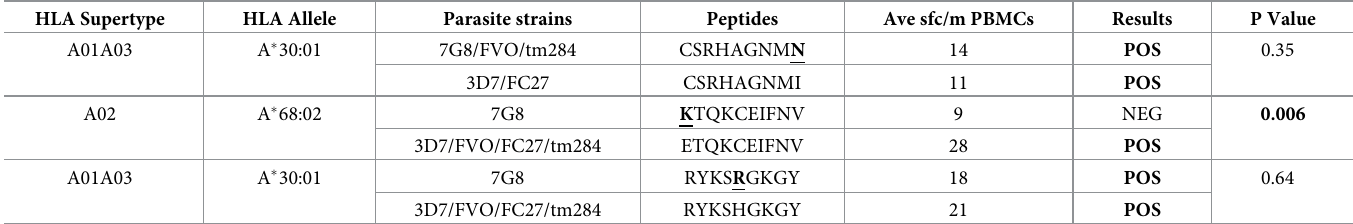
Table 2. Outcome of subject v02 PBMC stimulation with allelic peptide sets.